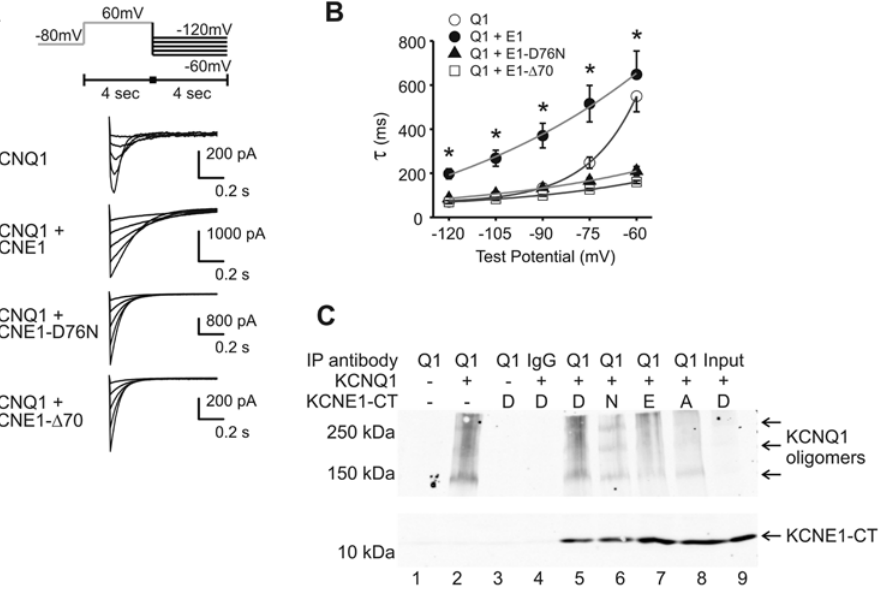
Figure 4. Deactivation rates are accelerated by both KCNE1-D76N and KCNE1- D 70. A) Current traces, with deactivation protocol in inset, and B) rates of deactivation plotted against voltage from CHO cells transiently expressing KCNQ1 (Q1) either without KCNE1 (E1), or with wild-type E1, E1-D76N, or E1- D 70. Asterisks (*) indicate significant change between wild-type E1 and both E1 mutations. n=6. C) Co-immunoprecitation experiment of C-termini KCNE1 with full length KCNQ1. Full length KCNQ1 was expressed with KCNE1 C-terminus (KCNE1-CT), either wild-type or with D76E, D76N, or D76A point mutations. Immunoprecipitation was performed with goat anti-KCNQ1 antibody, and immunoblot with rabbit anti-FLAG antibody (Santa Cruz). For controls, lane 1 shows results from untransfected cells, lane 2 from KCNQ1 alone, lane 3 from KCNE1 wild type (D76) alone, and lane 4 from KCNQ1 and KCNE1 with control antibody. The different KCNE1 forms are designated by the single amino acid letter at the 76 th